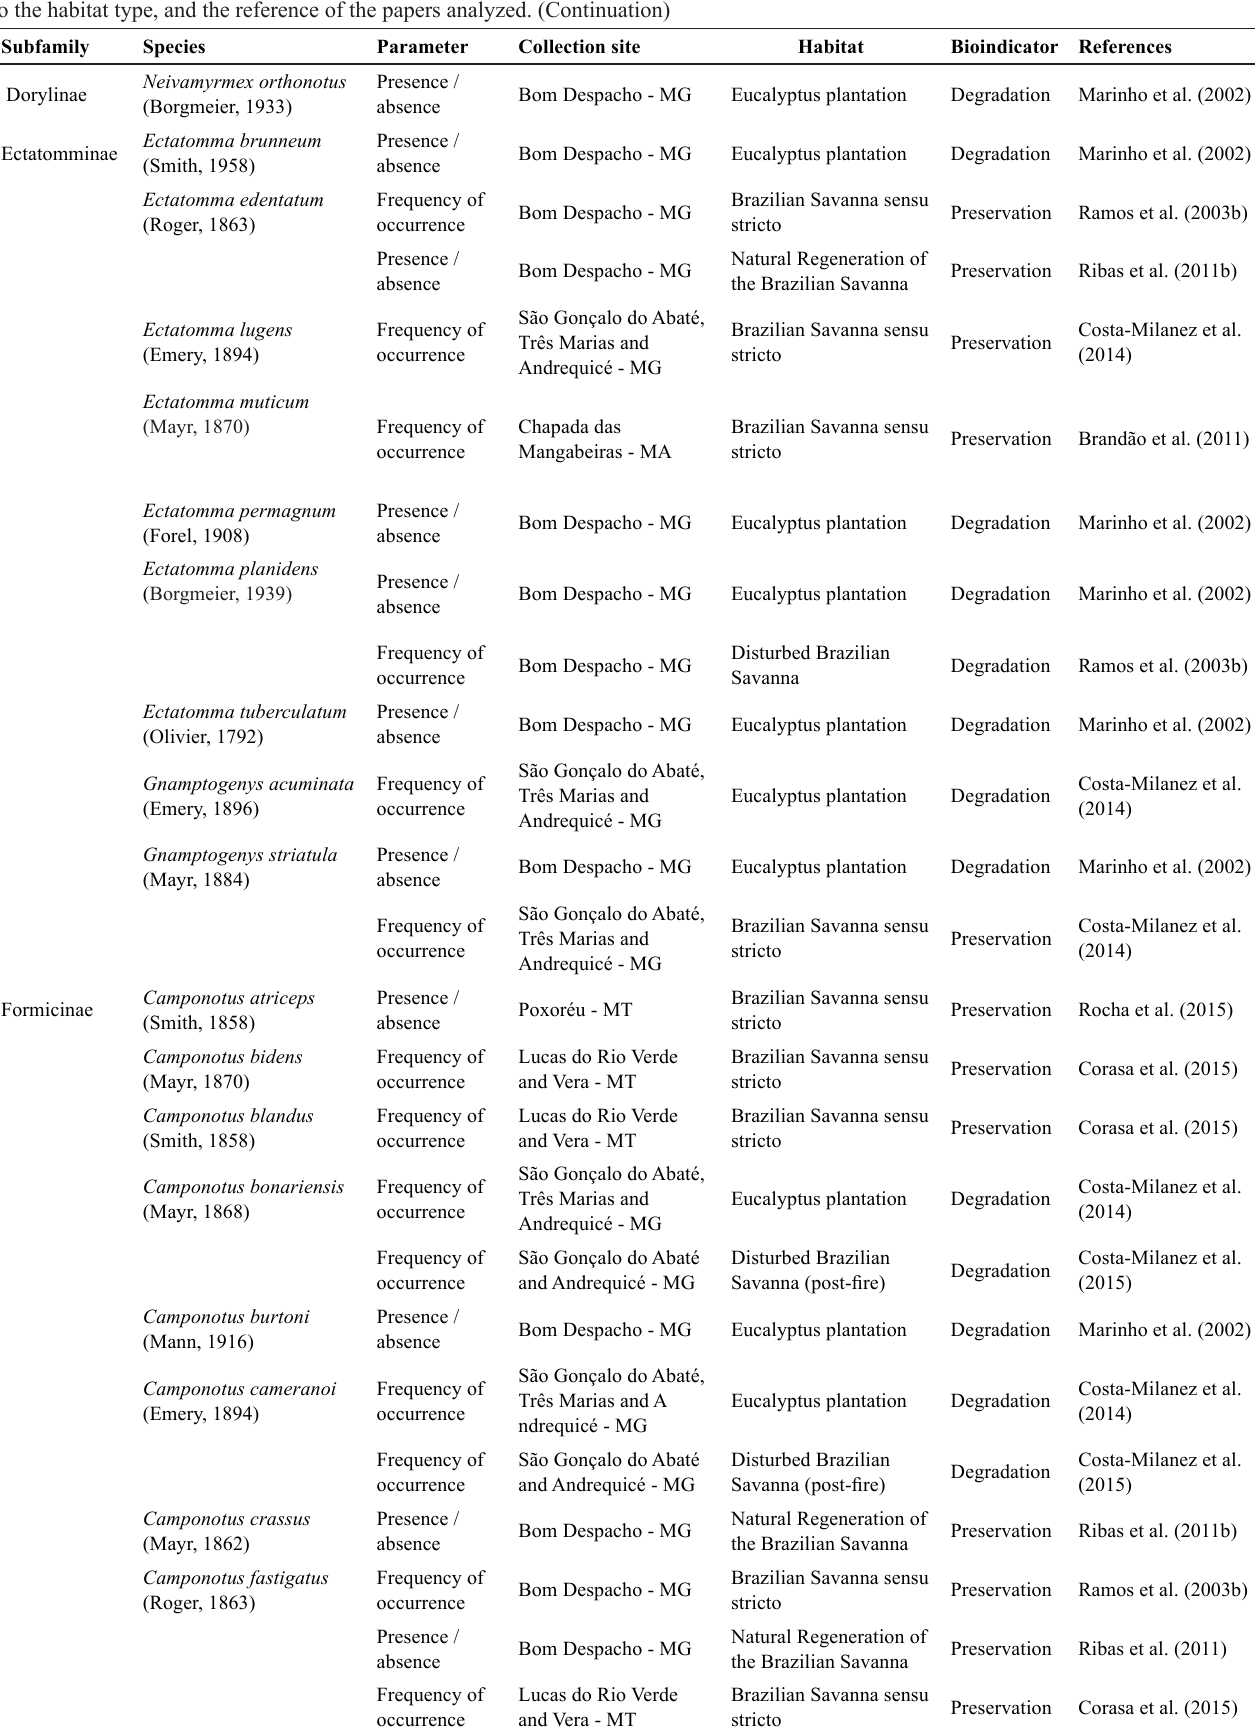
Table 3. Species of ants defined as bioindicators for preservation or degradation in the reference studys, indicating the parameter used to relate to the habitat type, and the reference of the papers analyzed.